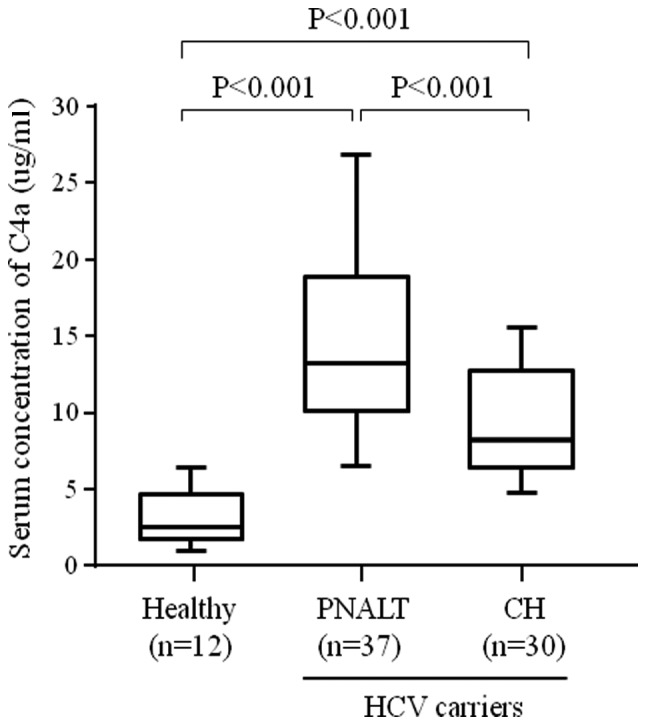
Serum concentrations of C4a determined by enzyme-linked immnosorbent assay in HCV carriers and healthy controls. Serum C4a levels were significantly higher in HCV carriers with PNALT than in HCV carriers with chronic hepatitis or healthy controls (P<0.001). Boxes indicate the median ± 25th percentile, the lower bar indicates the 10th percentile, and the upper bar indicates the 90th percentile. HCV, hepatitis C virus; PNALT, persistently normal alanine aminotransferase; CH, chronic hepatitis; C4a, complement component 4a.